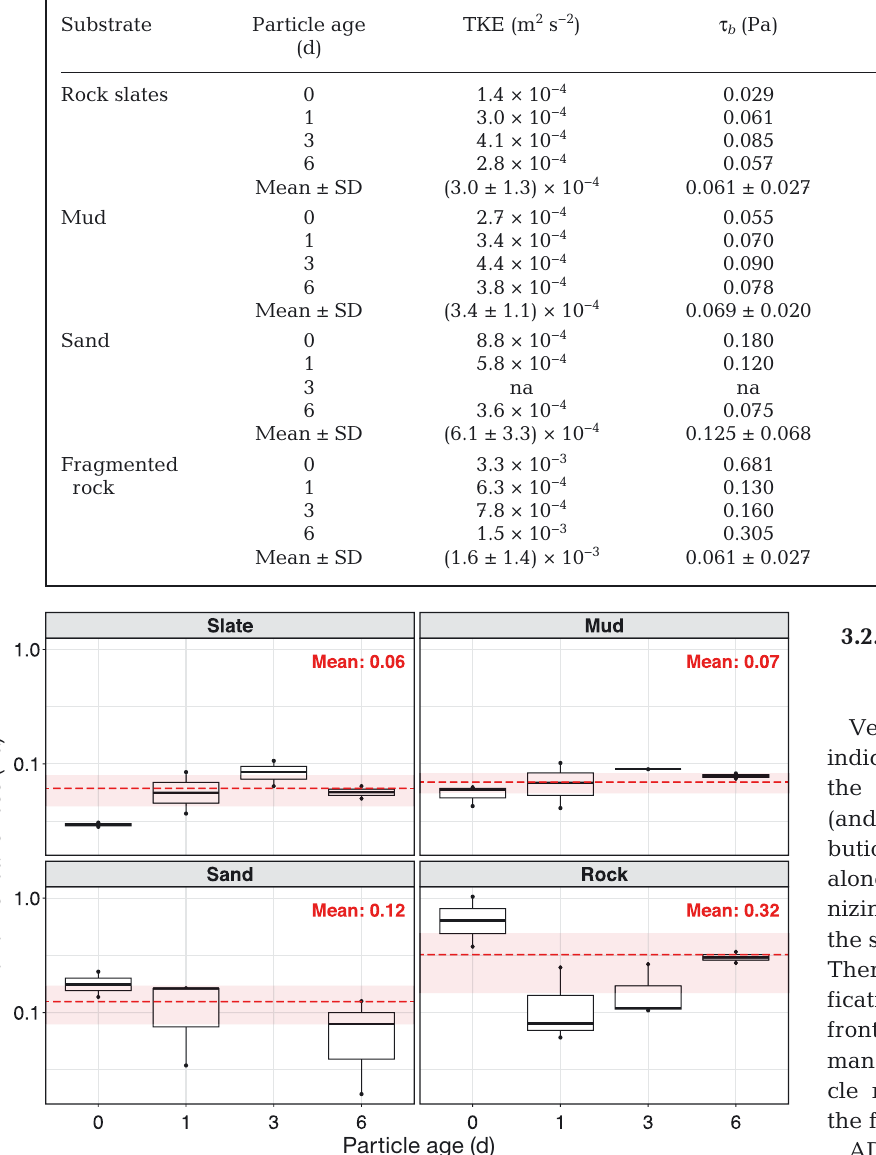
Fig. 3. Critical shear stress for resuspension of 0, 1, 3, and 6 d old faecal pellets over different substrates. The dotted red line shows the mean critical shear stress for resuspension over each substrate, and red-shaded areas around the mean are 95% percentiles based on a normal distribution. A log-scale is used for the y -axis due to the 10-fold difference in critical shear stress between the soft and coarse